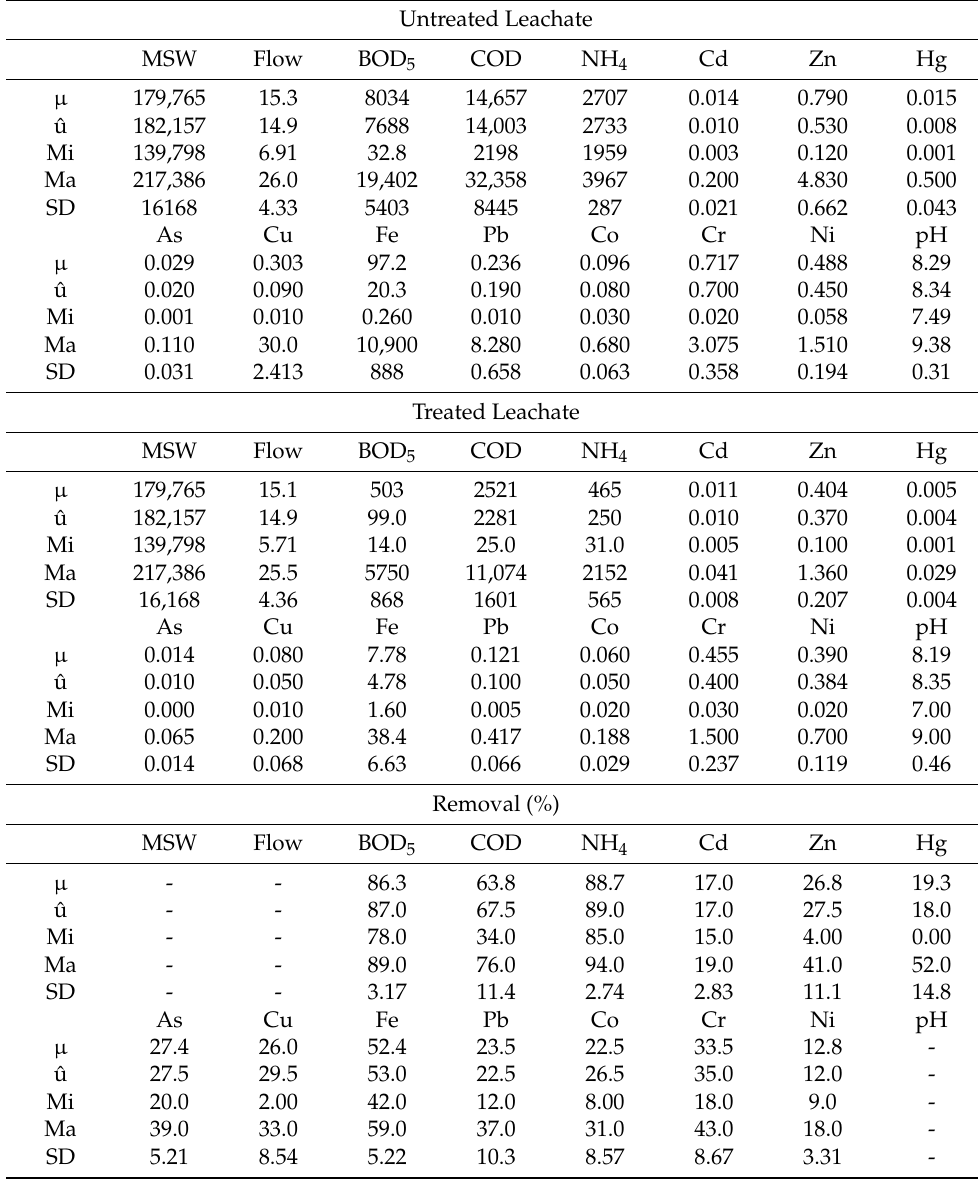
Table 1. Quantity of MSWs disposed, chemical characteristics of leachate, and removal efficiency from the treatment plant during the study